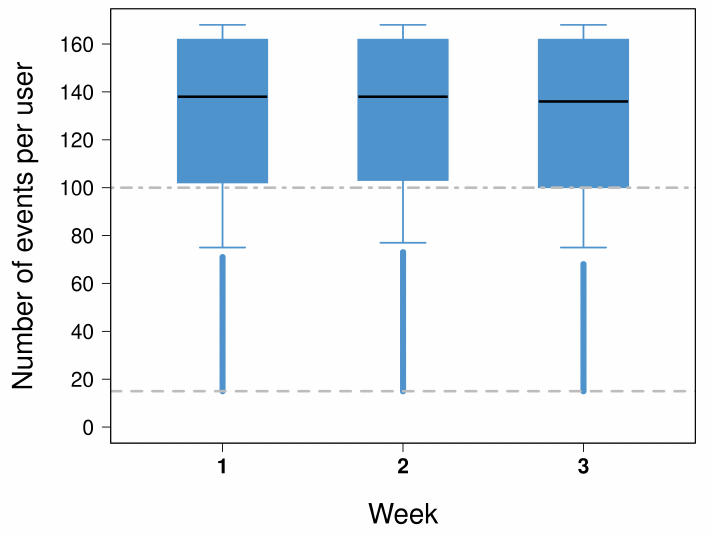
Figure A3. Boxplots of the number of events per reliable user according to the week of observation. The dashed grey line represents the minimum value (15 is the minimum value required to pass the first filter in the home identification). The dash-dotted line represents the limit of 100 events. The maximum value is 168 (number of hours in the week). Each boxplot is composed of the first decile, the lower hinge, the median, the upper hinge, and the last decile. The blue dots represent the